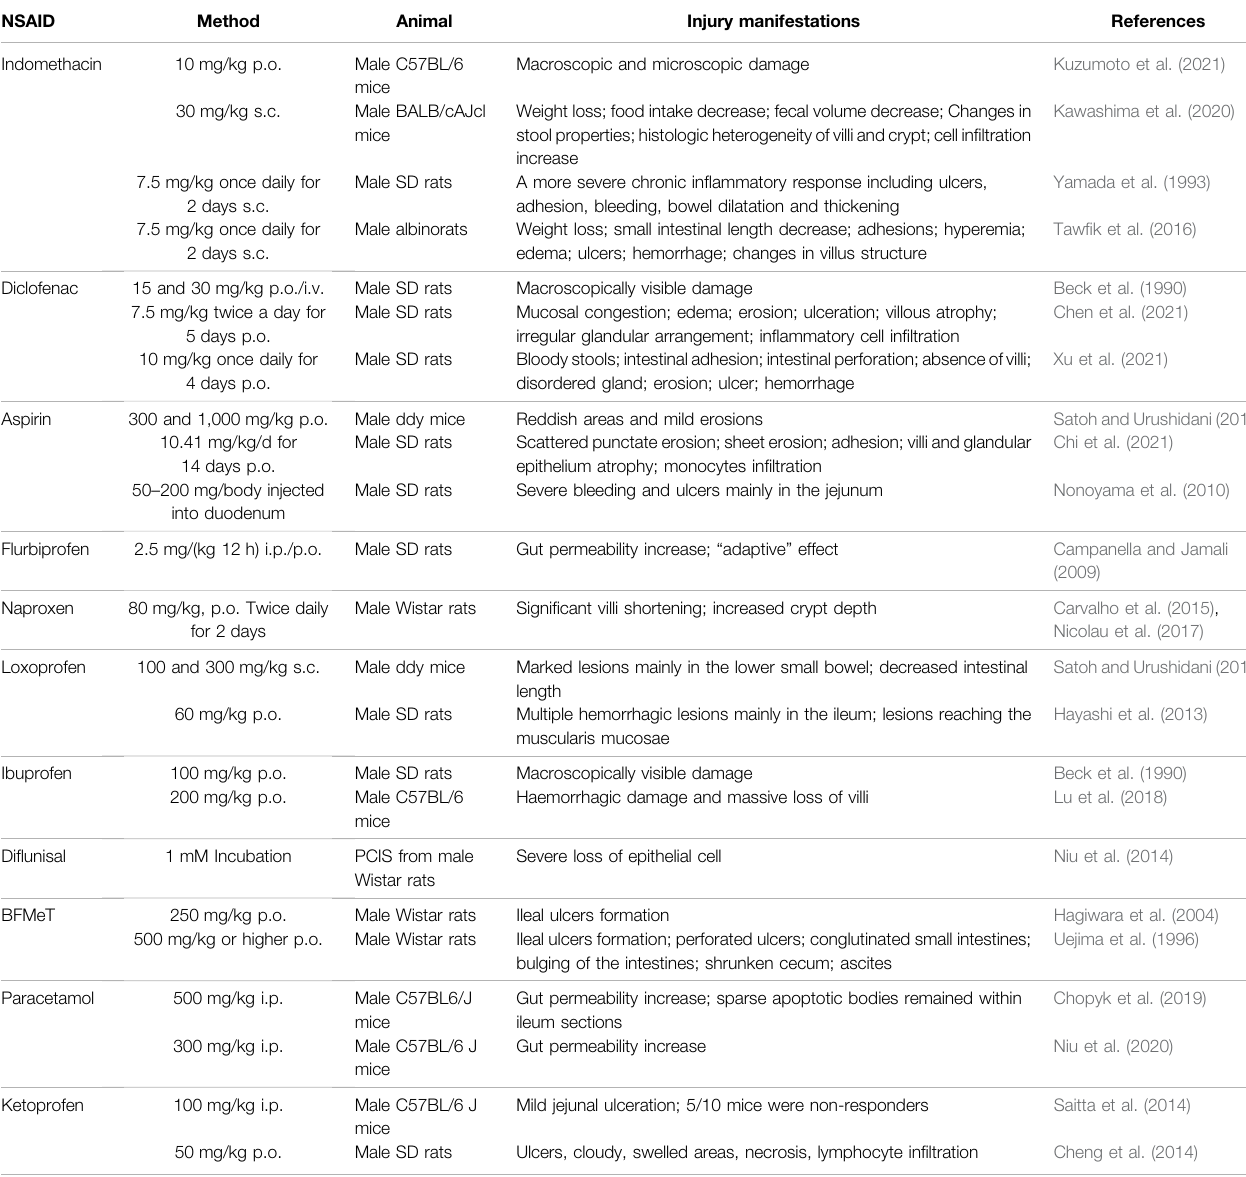
TABLE 1 | NSAIDs induced models of intestinal in fl